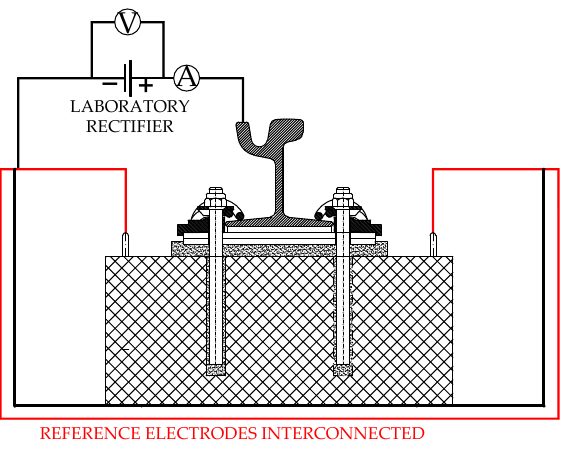
REFERENCE ELECTRODES INTERCONNECTED